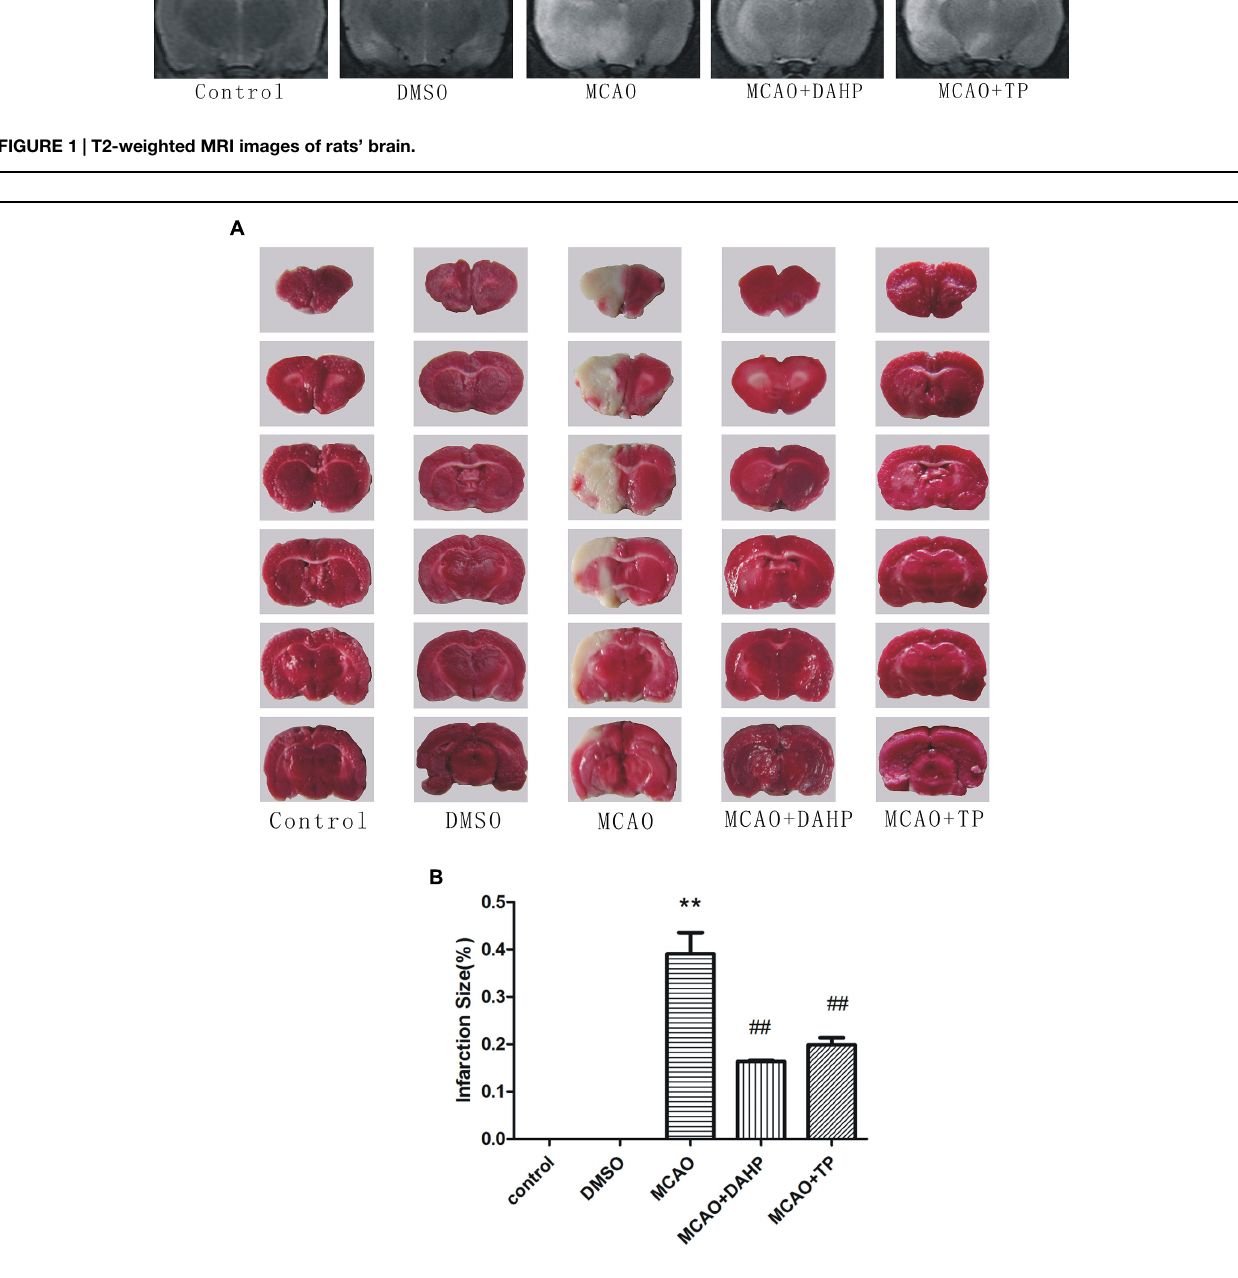
FIGURE 2 | 2, 4-diamino-6-hydroxypyrimidine and Triptolide (TP) reduced focal cerebral ischemia-induced injury. (A) Representative photographs of coronal brain sections stained with 2,3,5-triphenyltetrazolium chloride. (B) Summary of cerebral infarct size in brains. The infarct volume